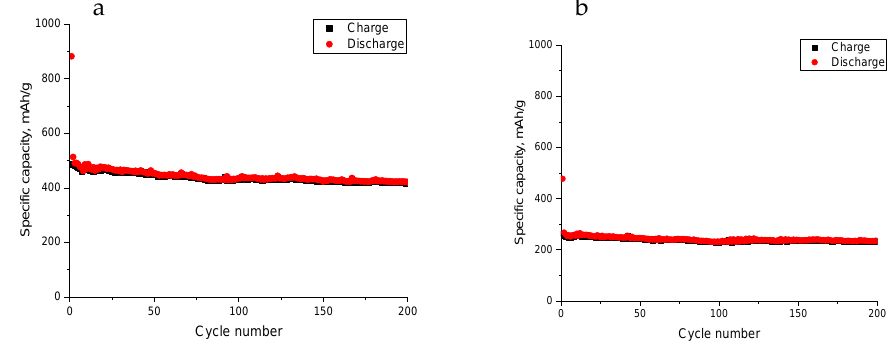
Figure 5. Cycling performance of: ( a ) flexible MoS 2 @Ge/CNFs and ( b ) Ge/CNFs. Chen et al. [22] fabricated MoS 2 @SnO 2 @C via hydrothermal synthesis and the reversi- ble capacity of approximately 400 mAh/g was reached in 150 cycles and the high electro-